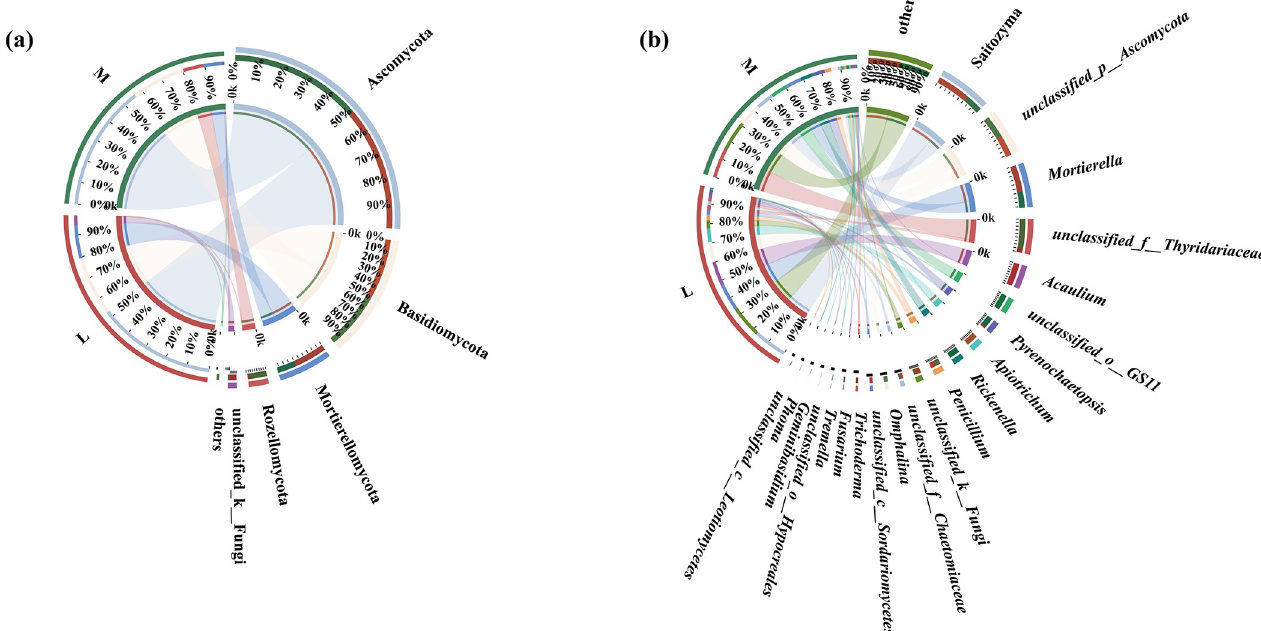
Fig 13. Distribution of soil-dominant fungi at phylum level (a) and at genus level (b) between moss- (M) and non-moss-growth (L) areas in litchi orchard.